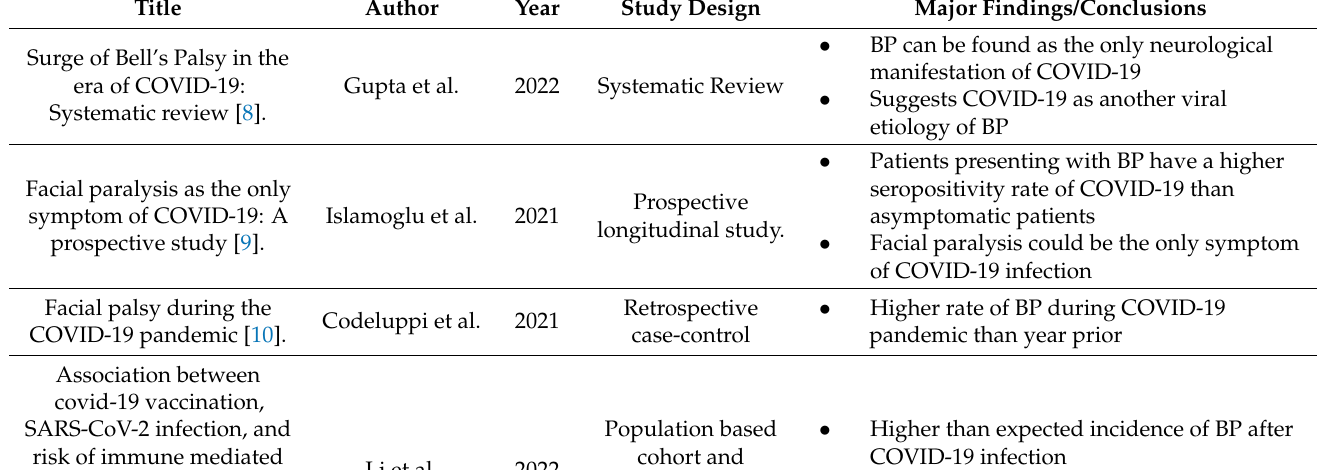
Table 1. Literature on the association between Bell’s palsy and COVID-19